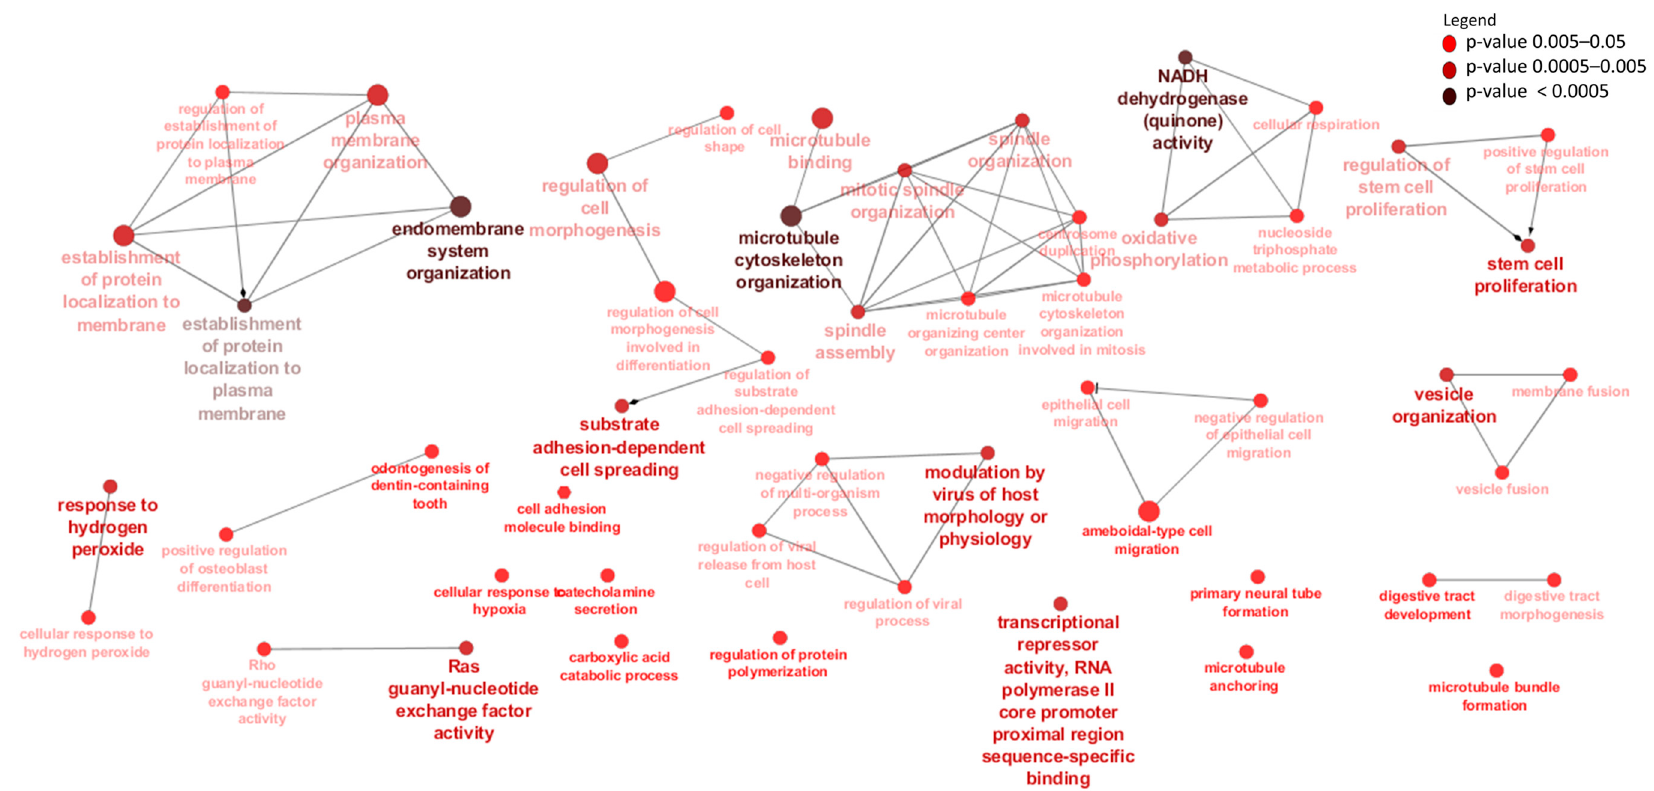
Figure 5. Gene ontology terms enriched for ileum lncRNA potential cis target genes.